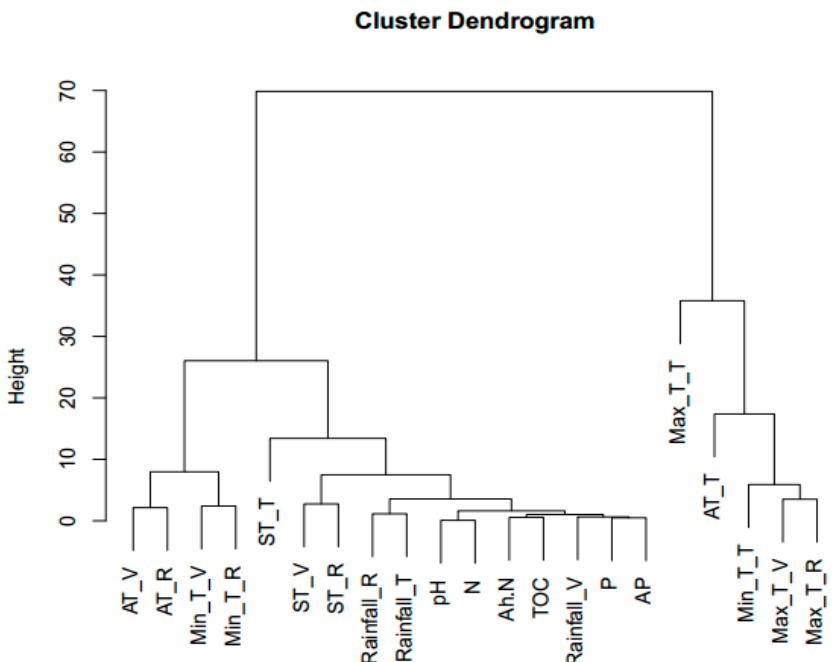
Figure 2. Cluster analysis of soil factors and meteorological factors on bioactive compounds and antioxidant capacities.